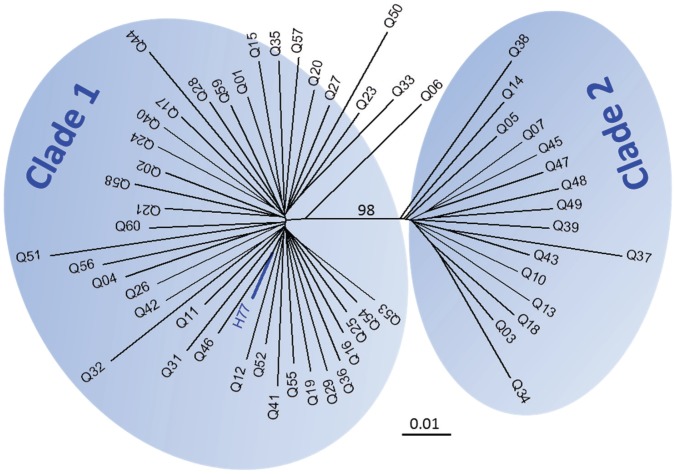
Neighbor-Joining tree of 56 nearly full-length HCV consensus sequences (each 8817 bp in length spanning from HCV Core to NS5b) under maximum composition likelihood model and gamma distribution of rate variation among sites (γ = 0.5). HCV genotype 1a prototype H77 strain was also included (blue branch).All strains were clustered apparently into two clades with 98% bootstrap support.